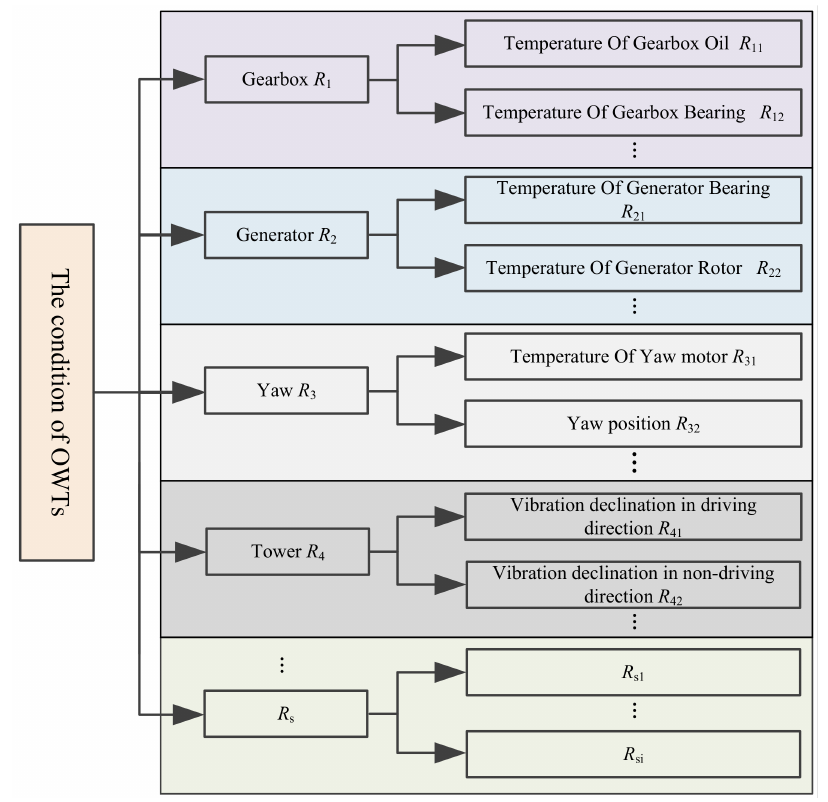
Figure 3. Evaluation system of OWTs.